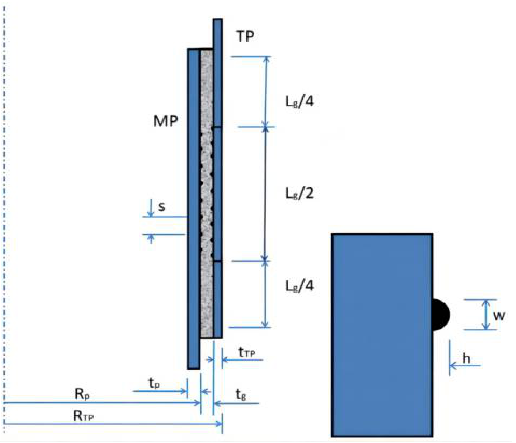
Figure 3. Geometric dimensions of grouted joint of single-pile foundation.